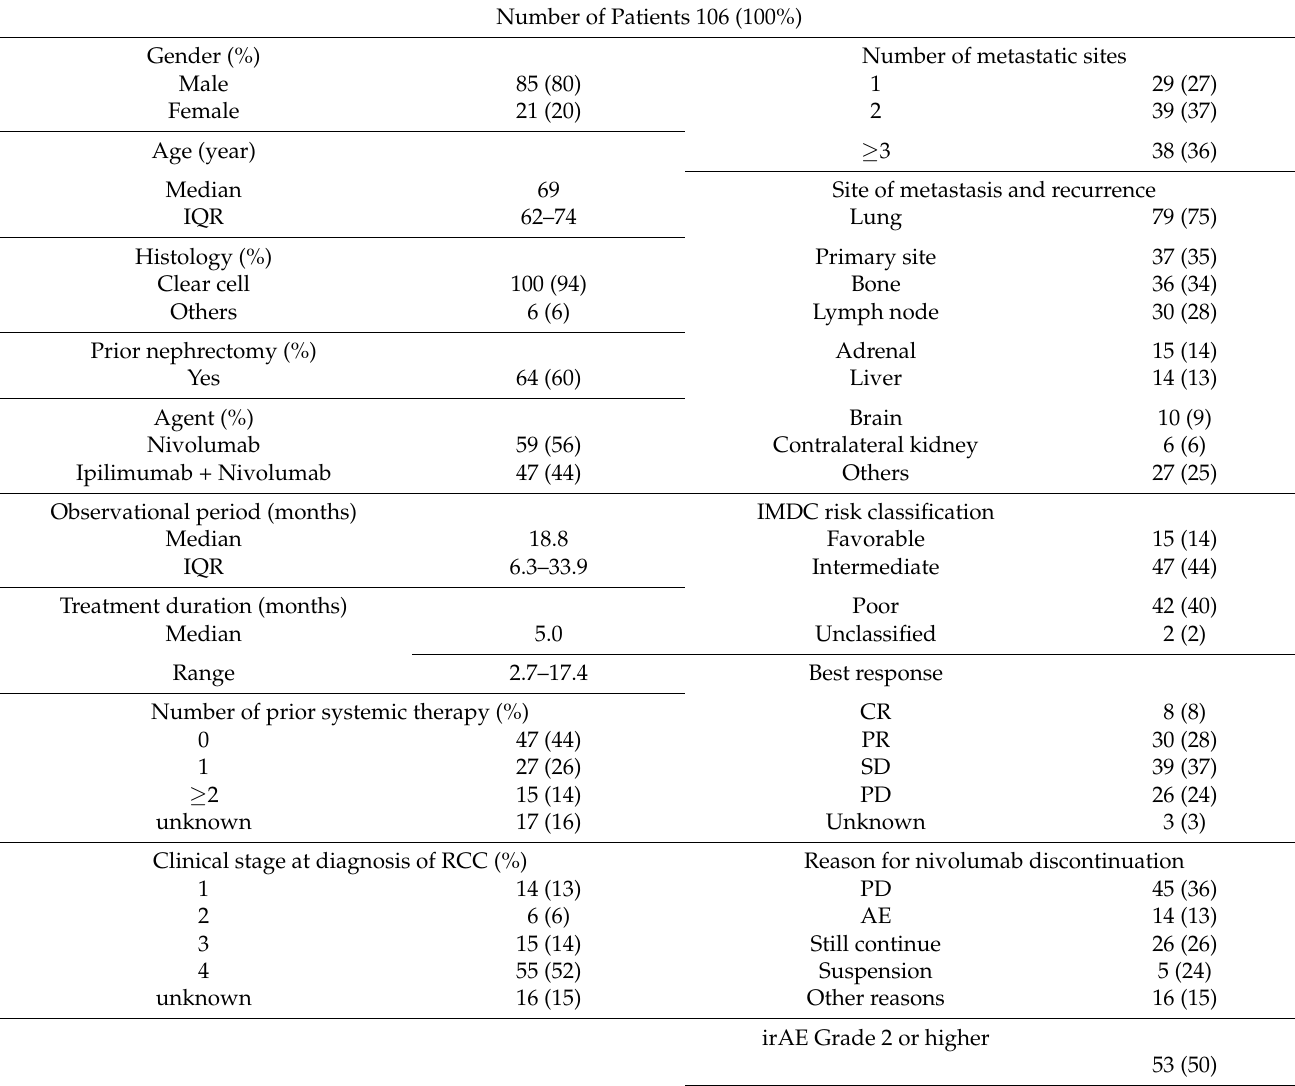
Table 1. Patients’